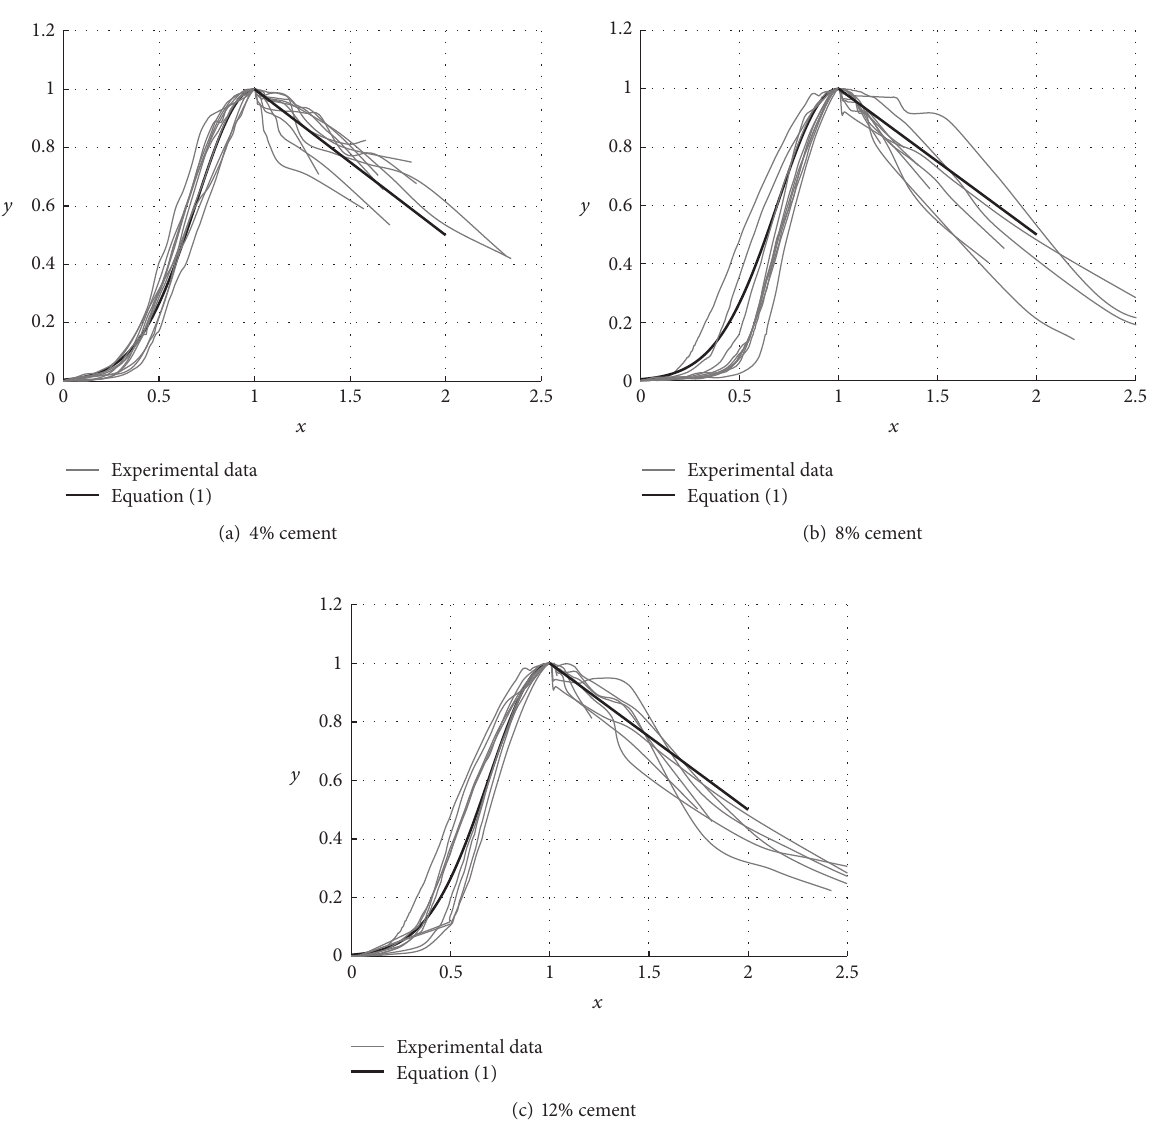
Figure 8: Dimensionless stress-strain curves of cement